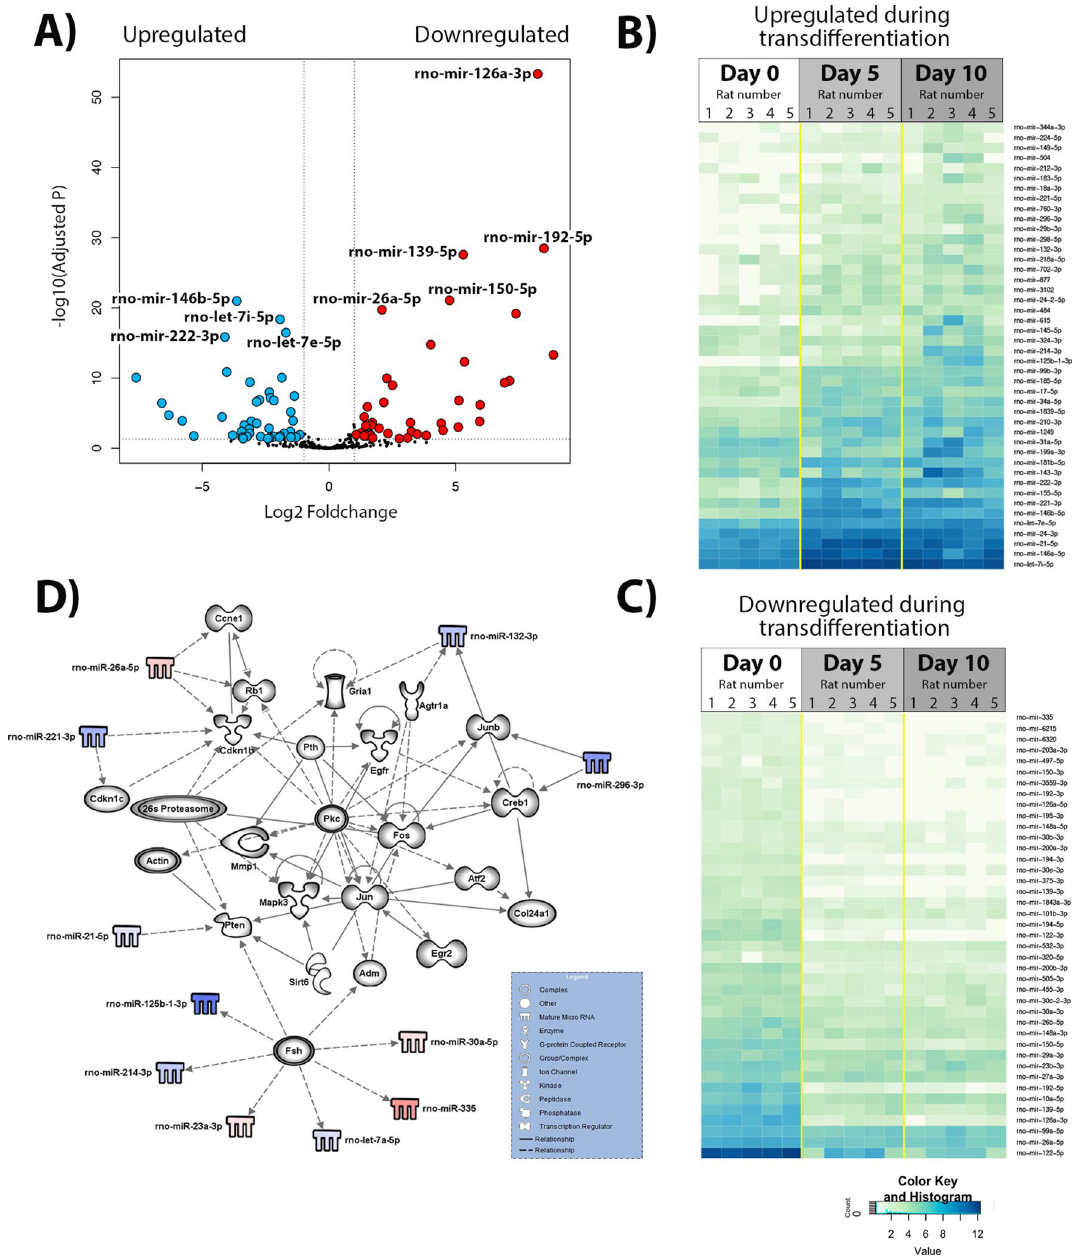
Figure 5. Differential expression of rat HSC activation during the perpetuation stage. ( A ) Volcano plot of the comparison between the quiescent HSC (day 0, n = 5) and fully activated HSC (day 10, n = 5). In blue—differentially under-expressed miRNA in day 0; in red—differentially over-expressed miRNA in day 0 (p-adjusted < 0.05 and foldchange > 1). ( B ) Heatmap of the 44 significant under-expressed miRNA in day 0 when compared to day 10, p-adjusted < 0.05. ( C ) Heatmap of the 41 significant miRNA over-expressed in day 0 when compared to day 10, p-adjusted < 0.05. ( D ) Biological network of differentially expressed miRNA. In blue and red, under and over-expressed miRNA, respectively. Shadowed in grey are molecules related to miRNA, as displayed on the legend. Lines represent different relationships between the molecules and